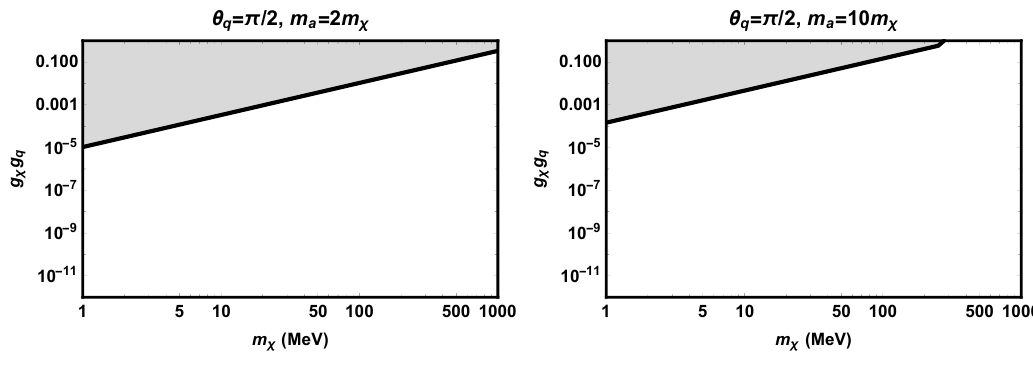
Figure 4 . Same as figure 3, except for θ q = π/ 2